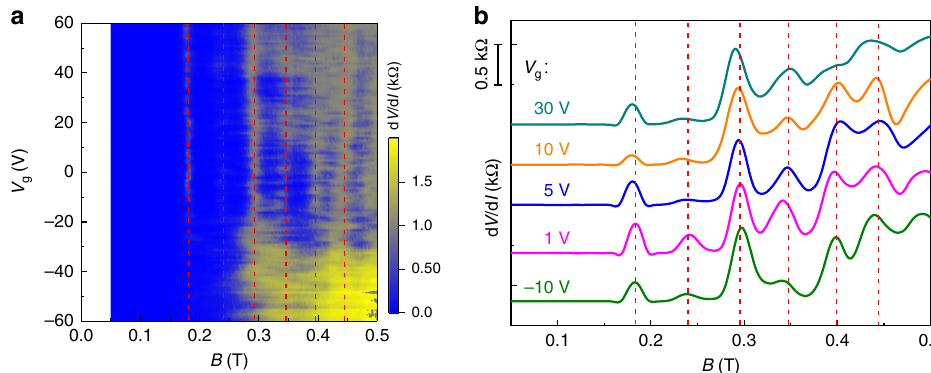
Fig. 4 The evolution of differential resistance with magnetic fi eld B and V g . a The d V /d I as a function of B and V g with I ac = 1 nA and without applying I dc . The vertical dashed lines are eyes guided. b The cut lines of d V /d I as a function of B extracted from a at V g = 30, 10, 5, 1, and − 10 V, respectively. The curves have been shifted for clarity. The d V /d I peaks emerge periodically with a period of Δ B